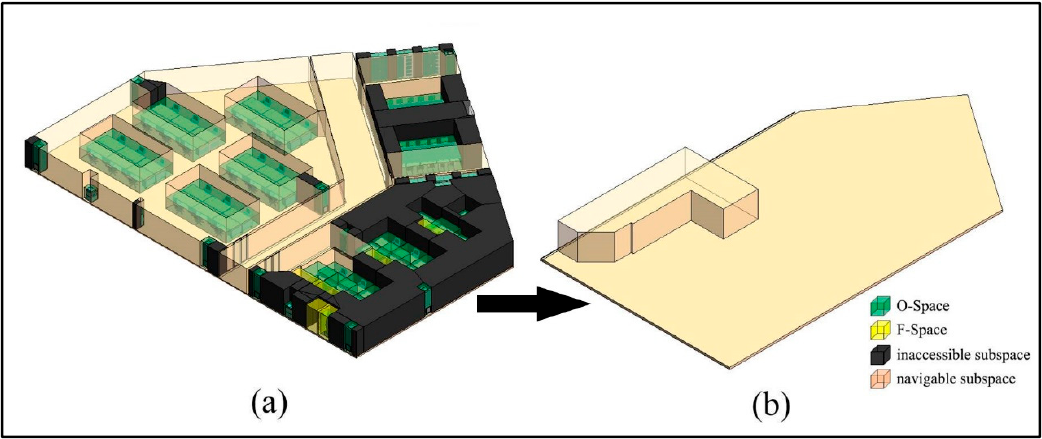
Figure 16. The CN-Space for a disabled adult male. ( a ) Inaccessible subspaces and CN-Space. ( b ) Partial detail presentation of the CN-Space.